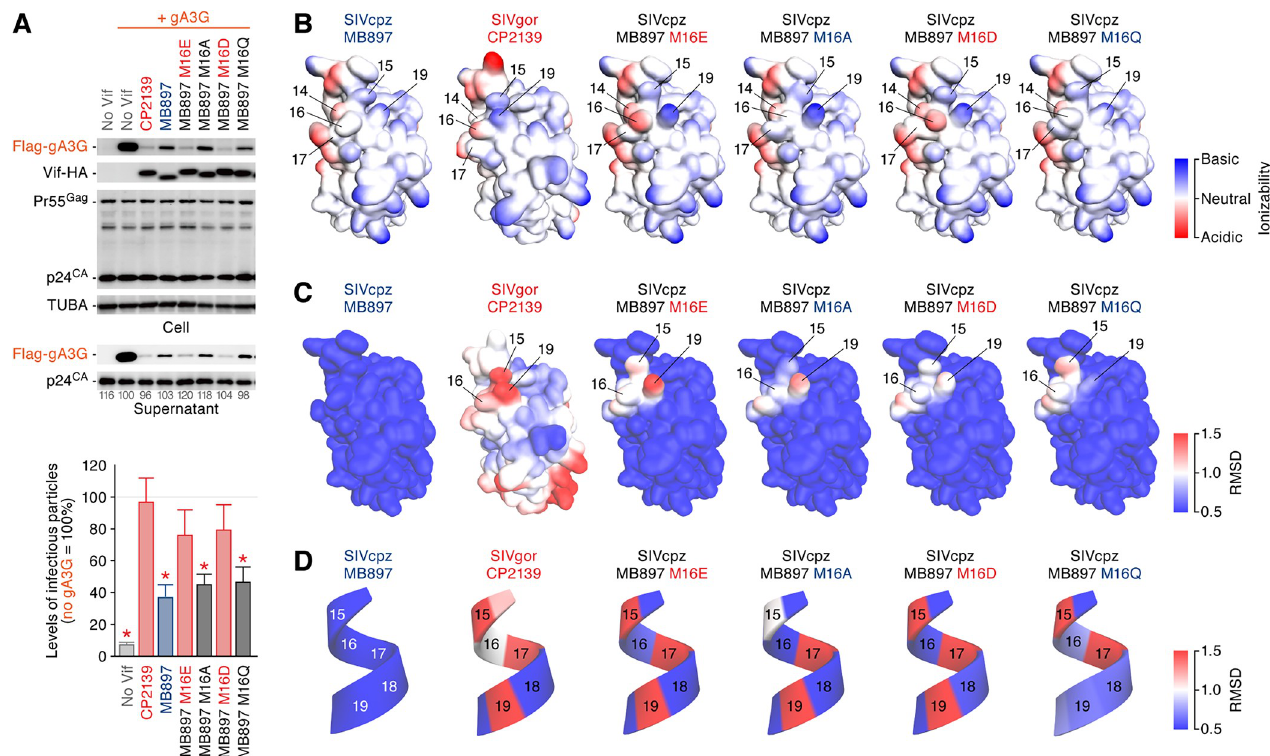
Fig 3. Importance of acidic residues at position 16 of SIVcpz Ptt to counteract gA3G. (A) Importance of acidic residue at position 16 of SIVcpz Ptt to counteract gA3G. HEK293T cells were co-transfected with pNL4-3 Δ vif (500 ng) and the expression plasmids for gA3G (50 ng) and the indicated Vif strains and derivatives (500 ng). Cells and supernatants were harvested at two days post-transfection and were used for Western blotting (top) and TZM-bl assay (bottom). For Western blotting, the input of cell lysate was standardized to TUBA, and representative results are shown. The band intensity of viral p24 was quantified and the intensity value of the gA3G expressing cells without Vif (second from the left) was set to 100%. For TZM-bl assay, the percentage of the value without gA3G is shown. The mean values of nine independent experiments ± SEM are shown. Statistically significant differences ( P < 0.05) versus “CP2139” are shown by red asterisks. (B-D) Structure homology models of Vif. The homology models are constructed based on the crystal structure of HIV-1M Vif (PDB: 4N9F) [29]. (B) Ionizability of each amino acid residue. Basic and acidic residues are indicated in blue and red, respectively. (C and D) Structural comparison. The topological changes of respective residues comparing to SIVcpz Ptt MB897 Vif are indicated based on the RMSD values of heavy atom positions. The whole structure model (C) and the cartoon model of the residues between 15–19 (D) are respectively shown.